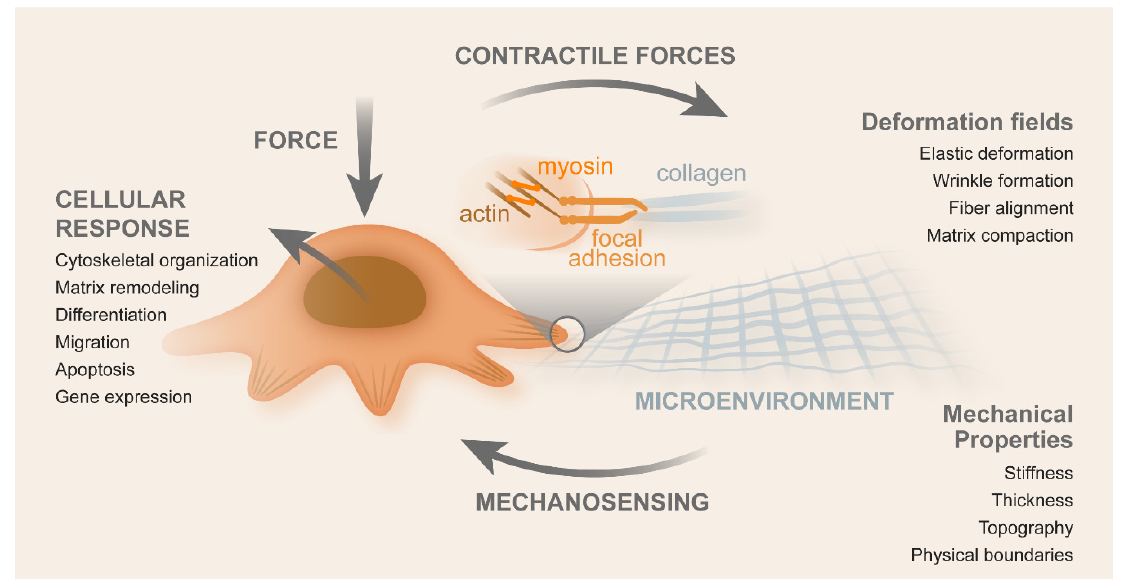
Figure 4. The feedback loop of force-deformation in cells and microenvironment. The cells sense the influence of the ECM microenvironment, such as stiffness, thickness, topography, and the physical boundaries with other cells (mechanosensing). These forces are transmitted to the interior of the cell through molecules that are bound to the cytoskeleton. The cytoskeleton transmits those forces to the nucleus, which will initiate the mechanics of cell response due to the activation of several gene expression pathways, that, in turn, will promote cytoskeleton organization, matrix remodeling, differentiation, migration, and apoptosis. The cytoskeleton organization and migration will produce the polymerization of F-actin filaments and the contraction of myosin motors, promoting cell motion, elastic deformation, and fiber alignment. Adapted from Mohammadi and McCulloch [84].